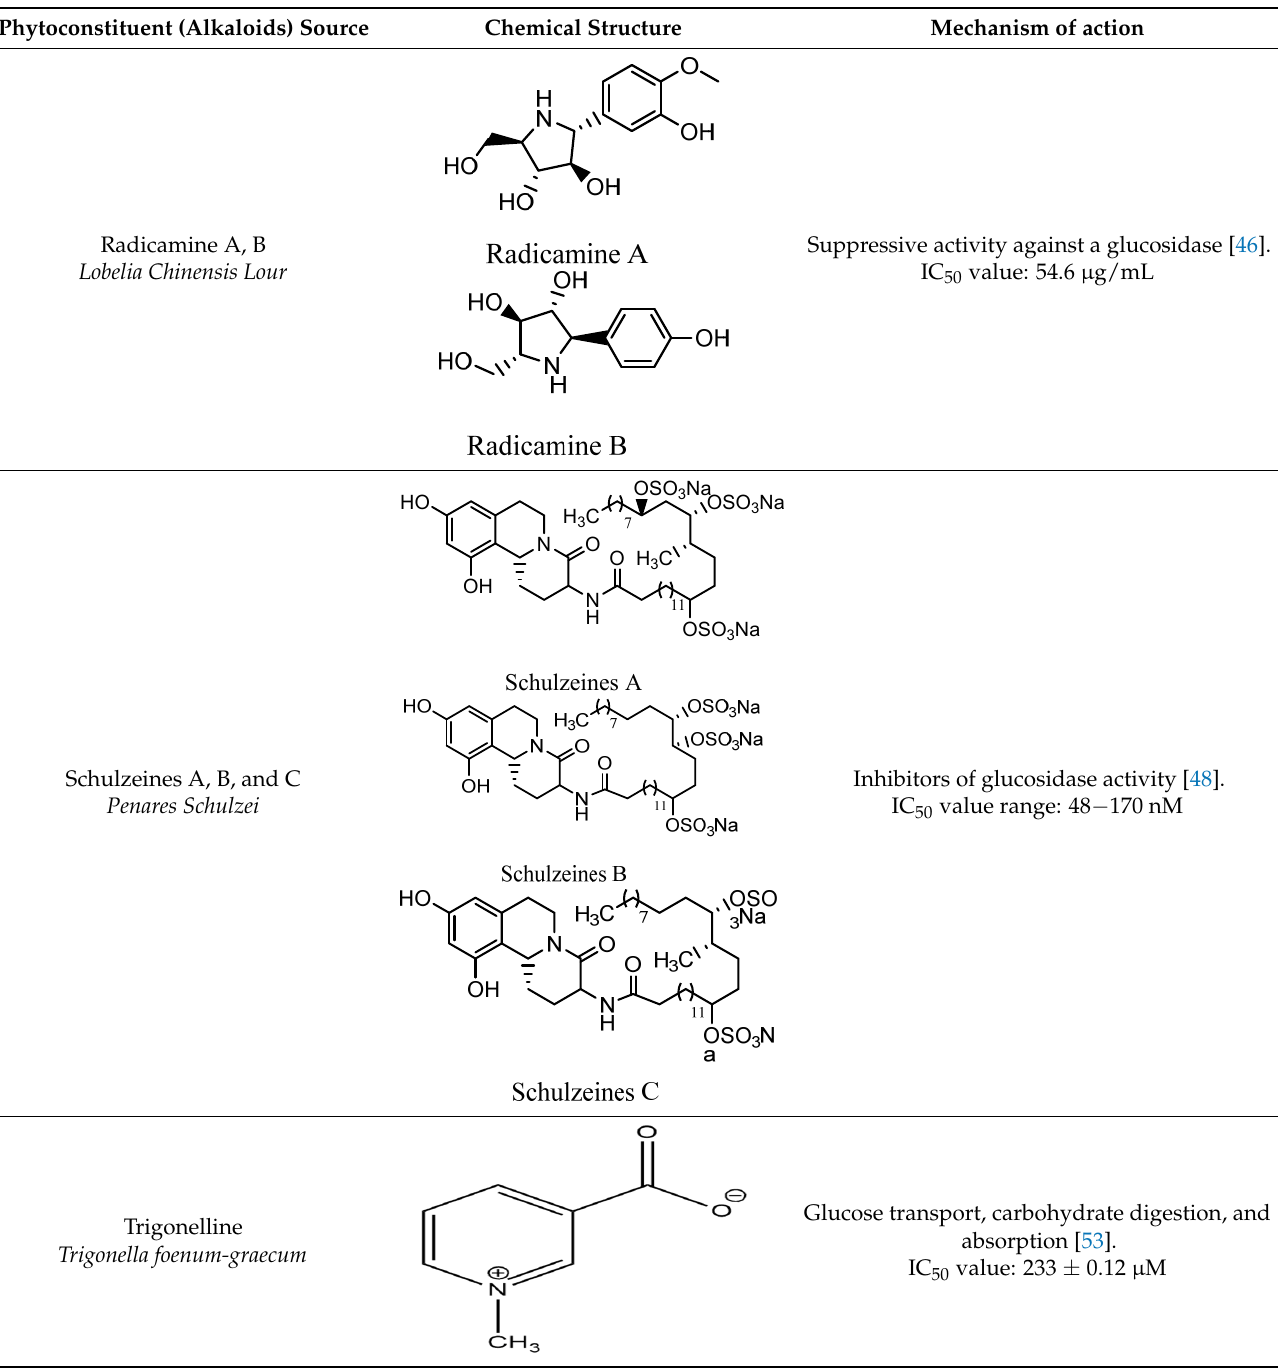
Table 1. Cont. Phytoconstituent (Alkaloids) Source Chemical Structure Mechanism of action